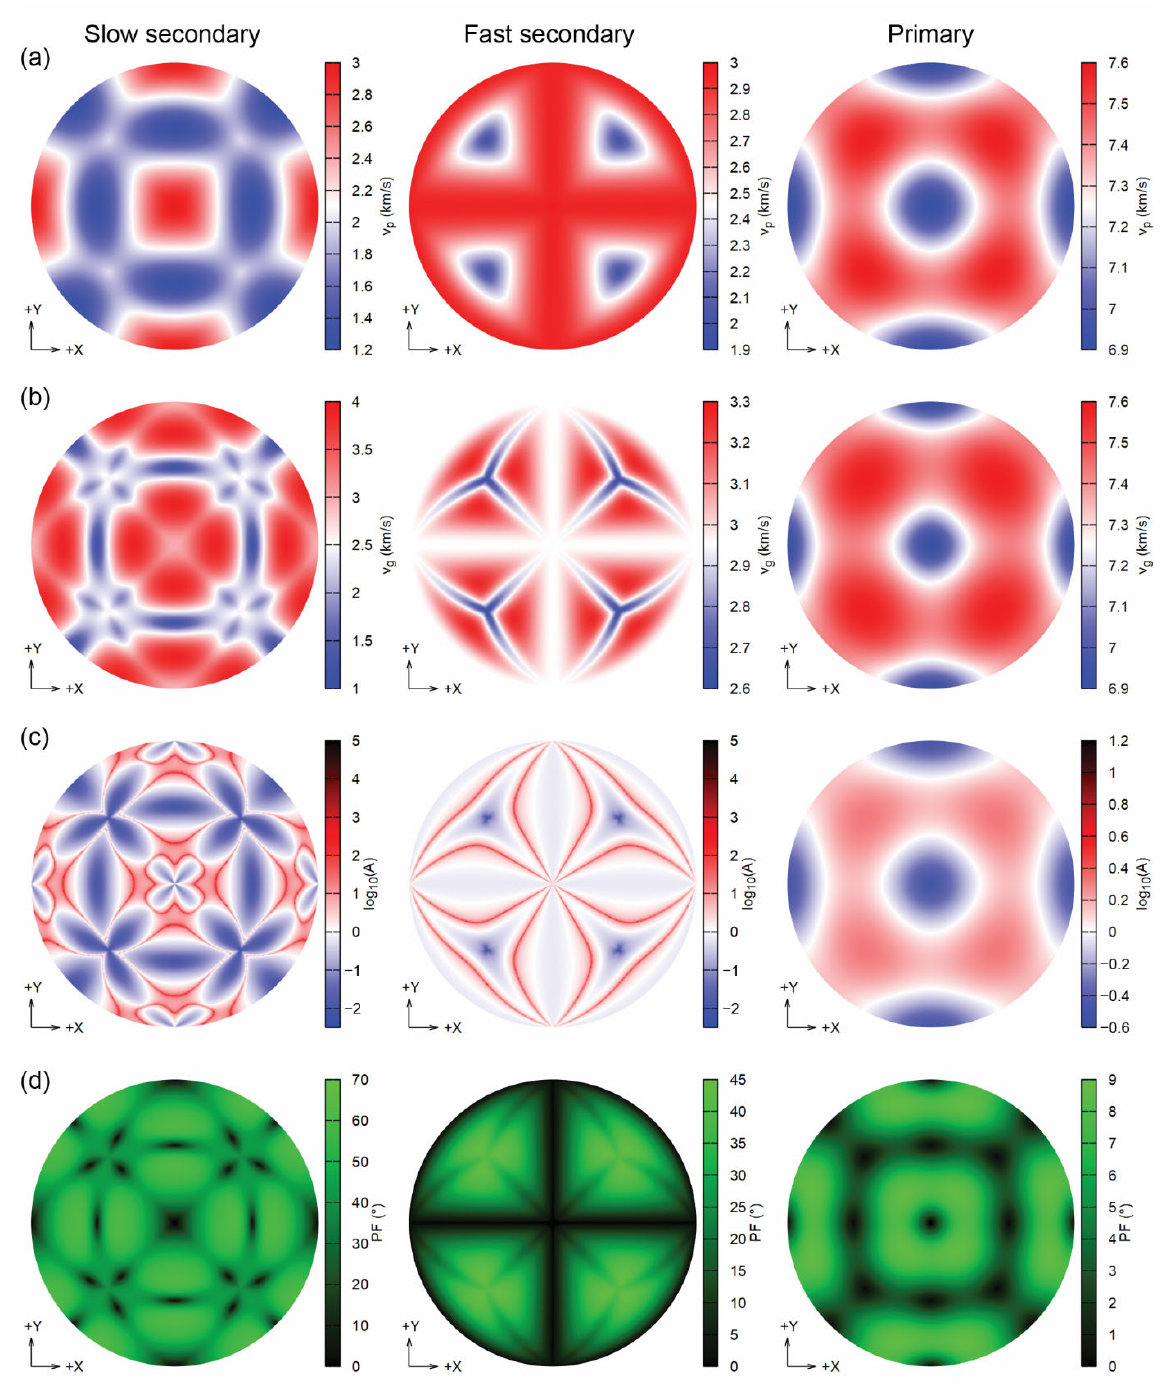
Figure 6. Analysis of the seismic wave velocities (Lambert equal ‐ area upper hemisphere projections) of sodalite at 12.8 GPa, showing ( a ) the phase velocities v P (km/s), ( b ) the group velocities v P (km/s), ( c ) the enhancement factor A and ( d ) the power flow angle (PF, °).